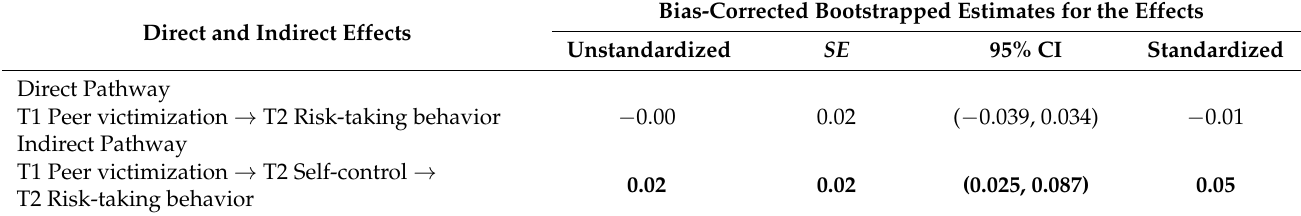
Table 3. Summary of the moderated mediation model.